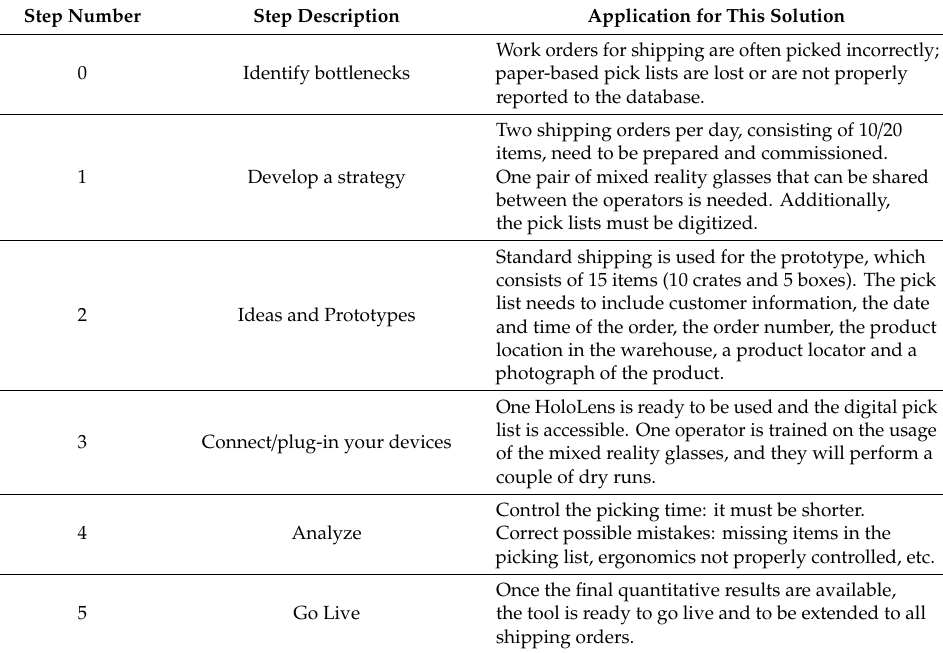
Table 5. Virtual reality—roadmap